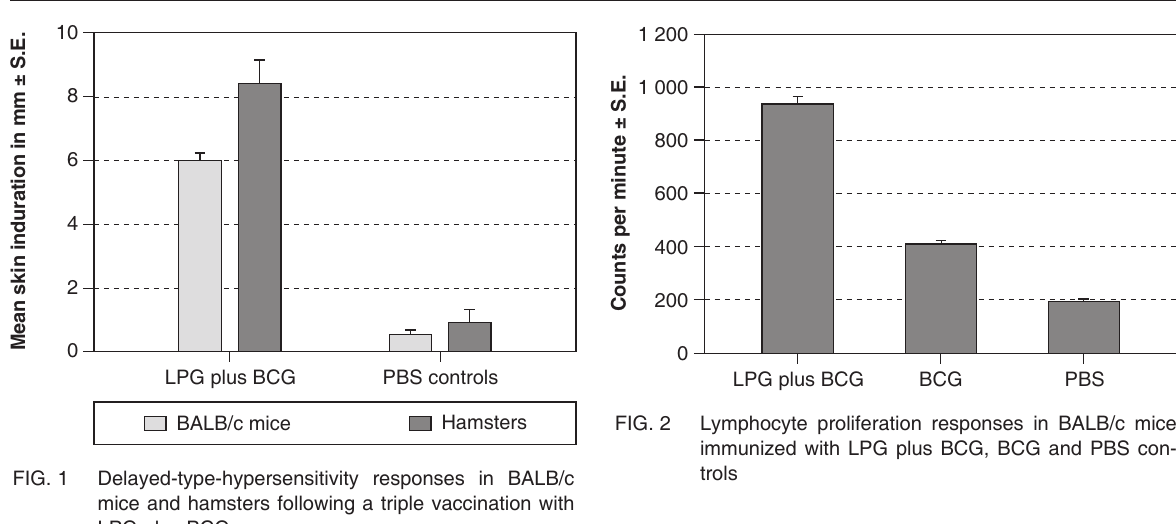
FIG. 1 Delayed-type-hypersensitivity responses in BALB/c mice and hamsters following a triple vaccination with